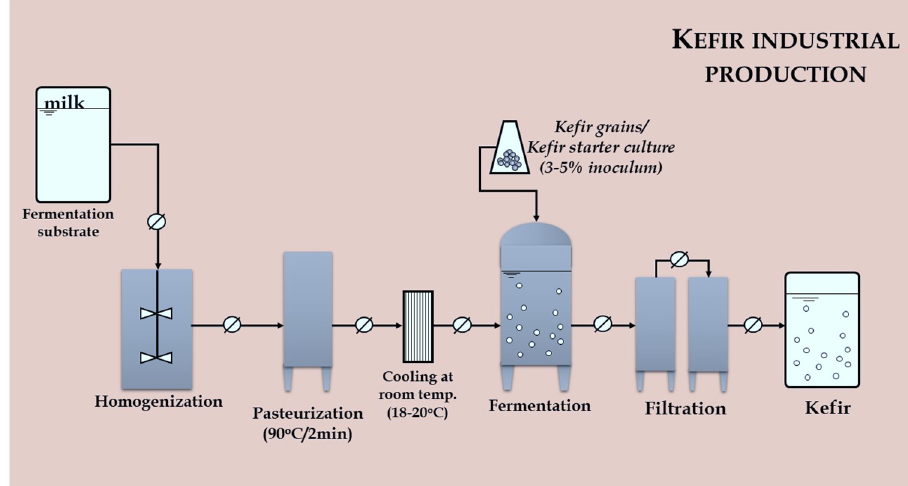
Figure 2. An outline of the main processes involved in industrial kefir production.